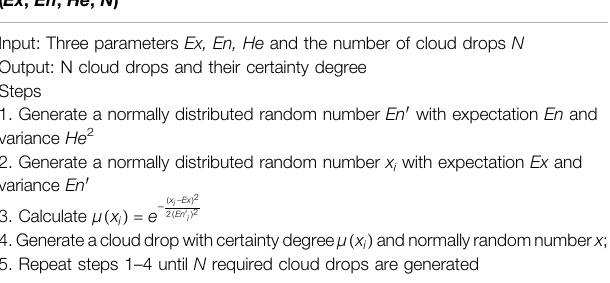
TABLE 1 | Algorithm for FNCT. Algorithm 1 Forwards normal cloud generator ( Ex , En , He , N